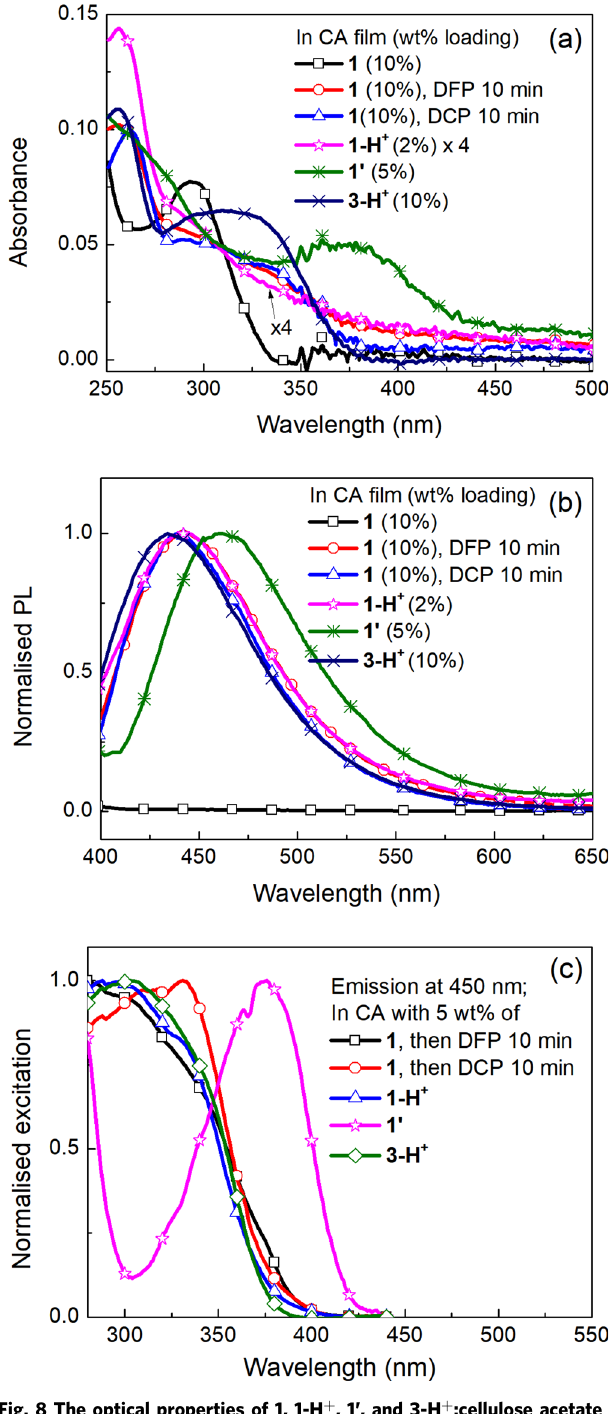
Fig. 8 The optical properties of 1, 1-H + , 1 ’ , and 3-H + :cellulose acetate fi lms compared to 1:cellulose acetate fi lms upon exposure to aged DFP or non-treated DCP vapor. a UV – vis, b emission (excitation wavelength = 365 nm), and c excitation spectra measured for an emission wavelength of 450